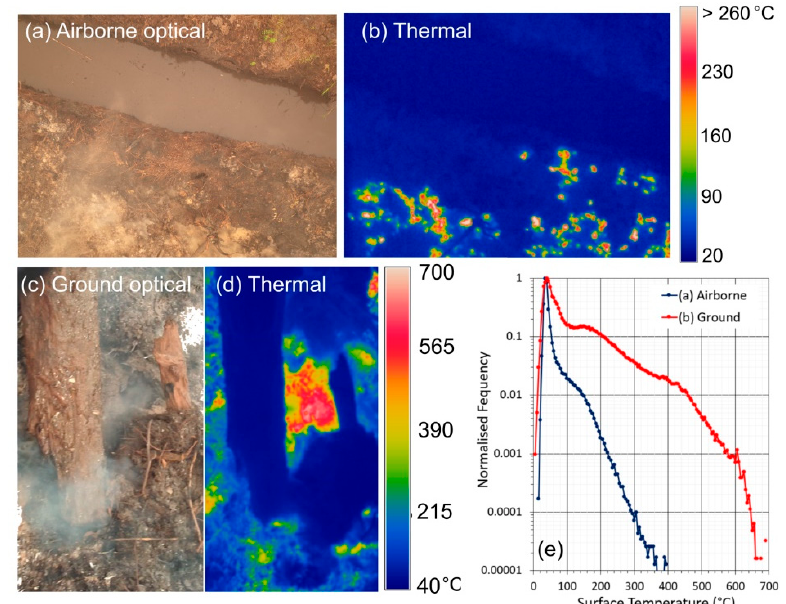
Figure 4. SE Asian peatland fire infrared surface temperatures and matched optical imagery. Data come from infrared camera measurements conducted on 14 October 2015 during the Central Kalimantan field campaign described in [10], and were acquired close to location 3 detailed therein. ( a ) Example airborne optical image of subsurface peat burning in a largely treeless area next to a drainage canal, captured from a UAV flying ~20 m height above ground, along with ( b ) the matching thermal (8–14 µm) brightness temperature image. ( c ) Example ground-based optical image of peat burns in a more forested area, where hot smoke is escaping from vents and holes and there is more woody material to burn. ( d ) Matching thermal brightness temperature image. ( e ) Normalised frequency of surface temperatures collected in the two different areas from multiple examples of the type of airborne and ground-based thermal imagery shown in ( b , d ), and where the more forested locations ( c , d ) show significantly higher temperatures, albeit still primarily coming from subsurface combustion.